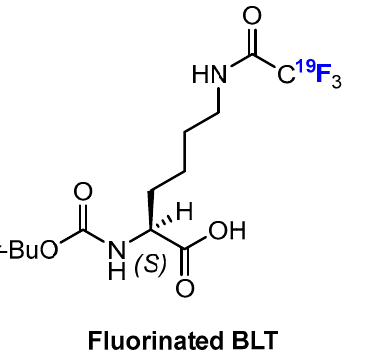
Figure 12. Chemical structure of fluorinated BLT by Sankaranarayanapillai et al. [86,87].